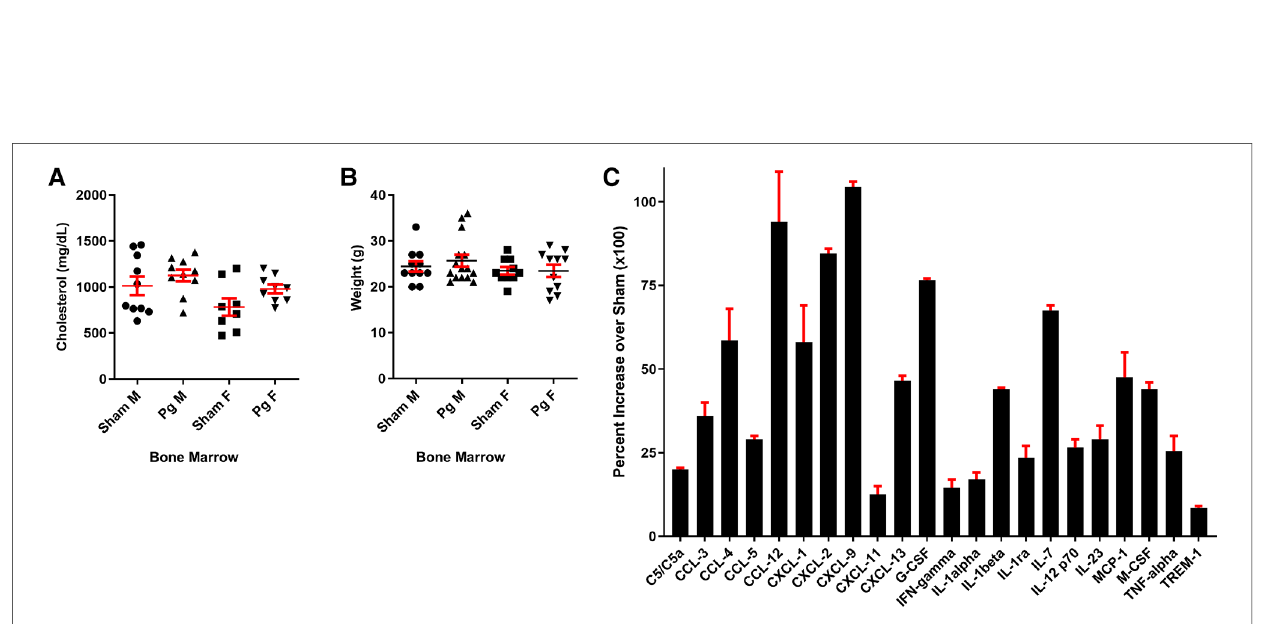
FIGURE 3 ( A ) Total plasma cholesterol and ( B ) weight at sacri fi ce. M=male; F=female ( n =8 – 15/group). ( C ) Signi fi cantly different cytokines/chemokines, represented as fold over sham, in macrophage lysates from male mice that received BM from Pg -inoculated donor mice ( n =5/group, pooled), out of a total of 40